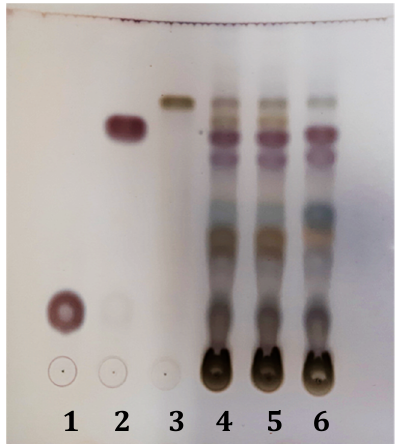
Figure 1. TLC analysis of the two spagyric tinctures, 014 and 019. Mobile phase: EtOAc/HCOOH/CH 3 CO 2 H/H 2 O (100:11:11:26 v / v ); visualization with AS (see Section 4.4). Harpagide, 1; harpagoside,